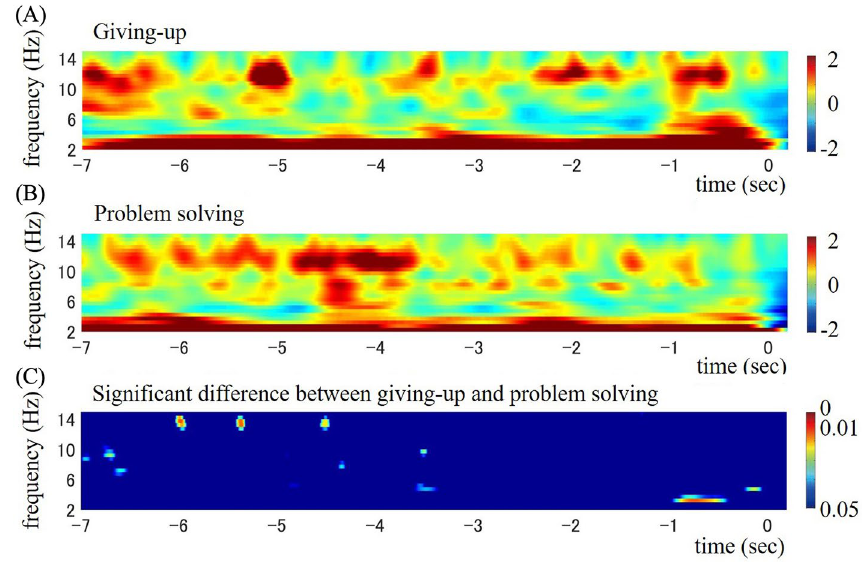
Figure 2. Time–frequency maps of frontal (Fz) amplitudes (μV) for seven seconds from the onset of keypress: ( A ) giving-up and ( B ) problem-solving conditions. ( C ) Statistically significant differences (p-values between 0.05 and 0.00) between the